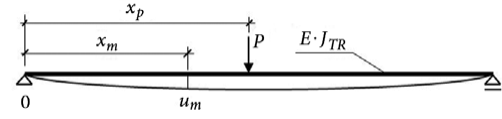
Fig. 6. Computational model to set coefficient of support elasticity due to vertical displacement resulted from flexural stiffness of truss girder